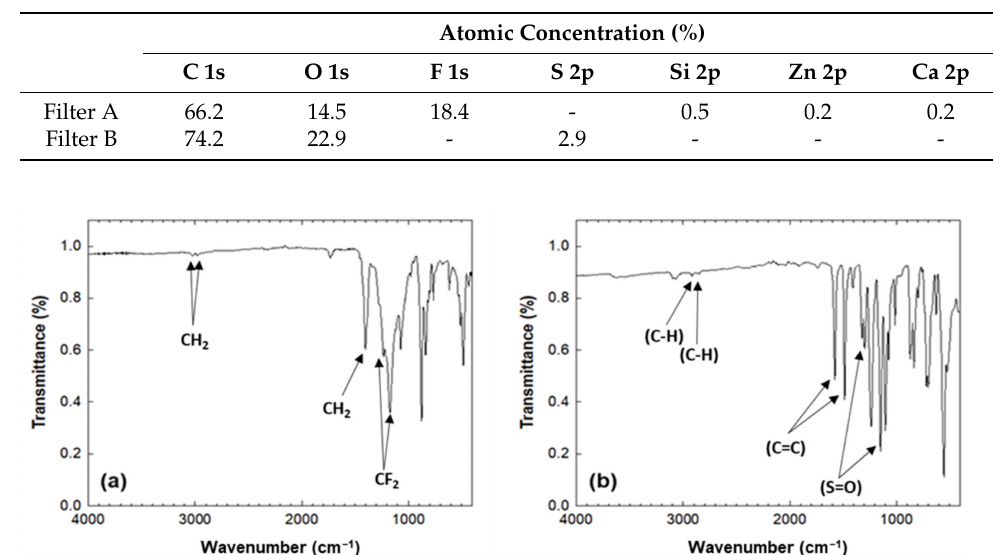
Figure 2. ATR-FTIR spectra for ( a ) filter A and ( b ) filter B.